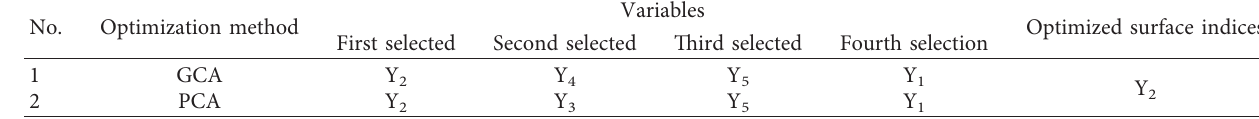
Table 8: Optimized linear